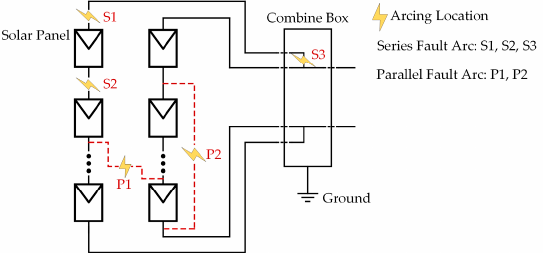
Figure 1. Direct current (DC) fault arc classifications in a photovoltaic (PV) system.